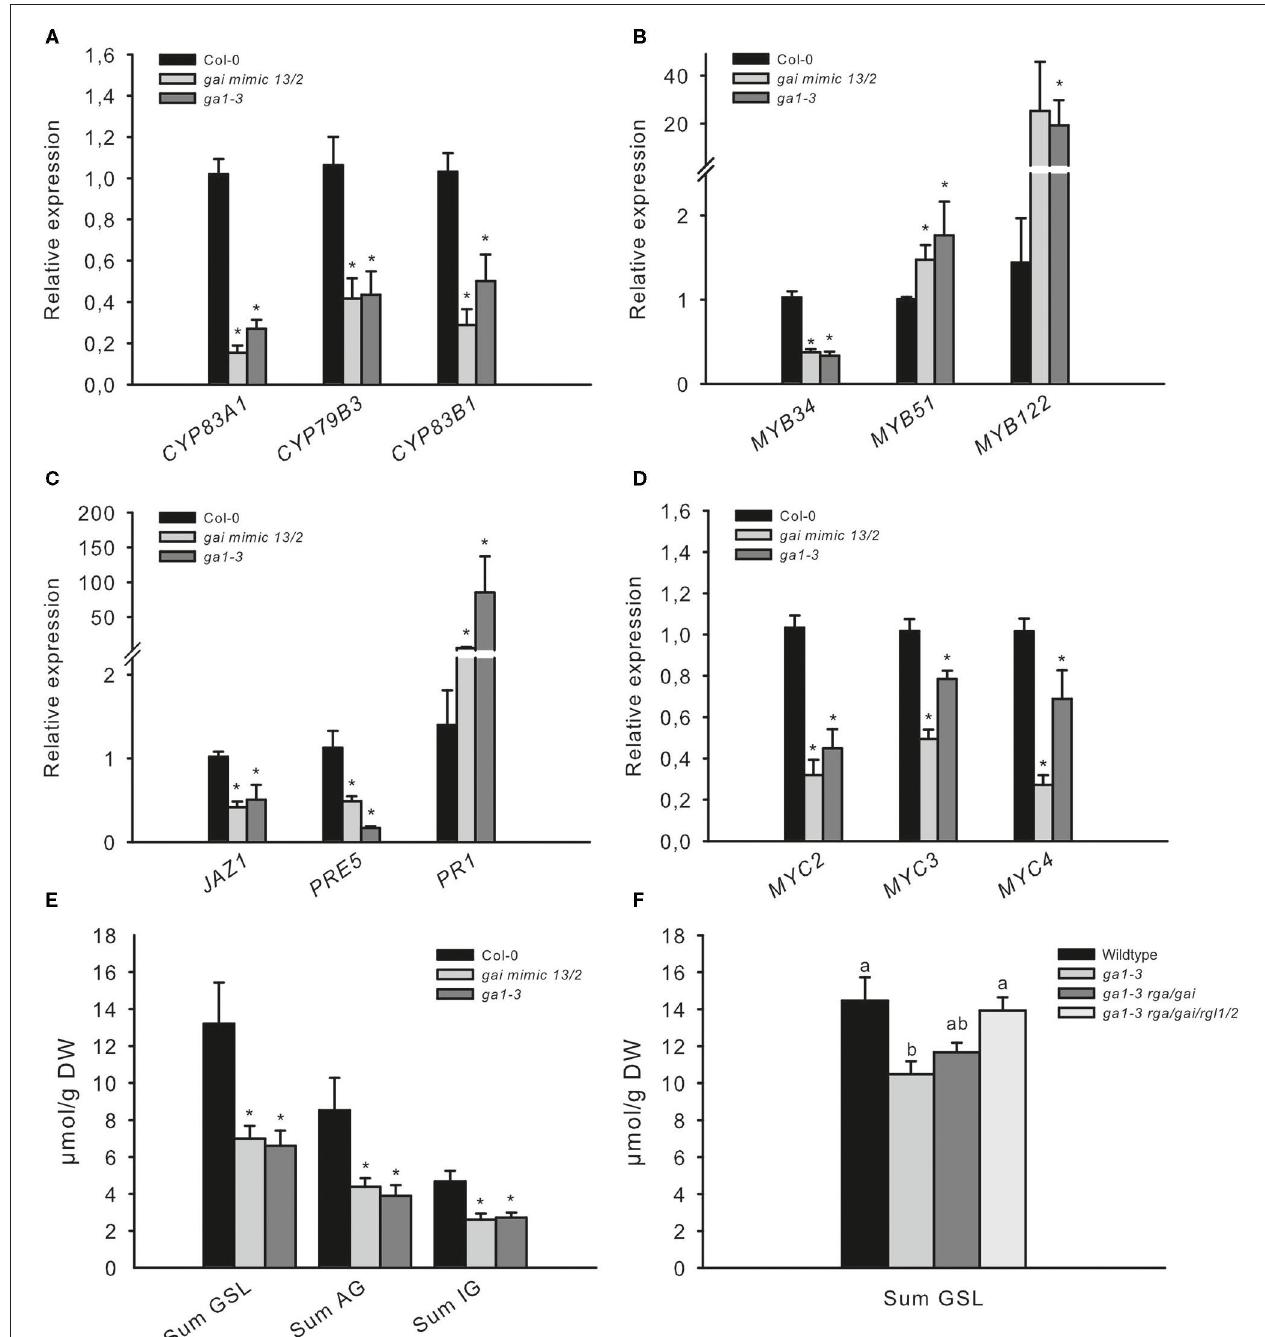
FIGURE 3 | The low GSL chemotype and low JA signaling phenotype in ga1–3 and gai mimic mutants resemble those of the cop1 mutant. To assess whether high DELLA levels influence the GSL level and related defense gene expression, two DELLA-accumulating mutants were tested. The expression of GSL genes (A) , HIG/MYB regulators (B) , hormone marker genes (C) , and MYC genes (D) was investigated in leaves of 6-week-old plants. Data are means ± SE from three independent experiments with three biological replicates in each ( n = 9). Data for GSLs (E) are means ± SE from five independent experiments with four biological replicates in each ( n = 20). Values marked with asterisks differ significantly from Col-0 (Student’s t -test; p < 0.05). The effect of attenuated DELLA levels in ga1–3 was tested in 6-week-old plants. Data (D,F) are means ± SE from three independent experiments with four biological replicates in each case ( n = 12). Values marked with different letters differ significantly from each other (the Kruskal–Wallis test followed by a Mann–Whitney pairwise test with Bonferroni-corrected p -values, p < 0.05).